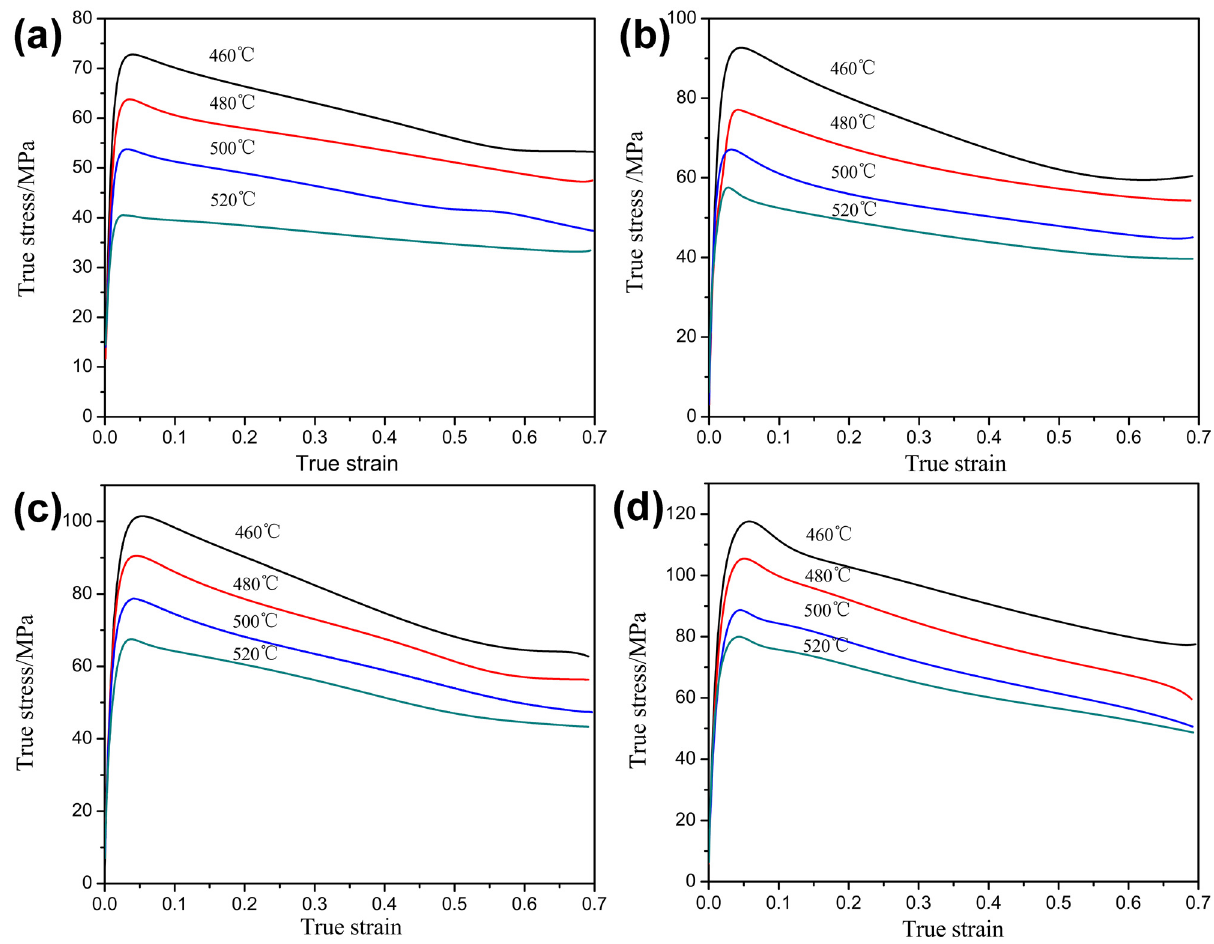
Figure 4: The true stress – strain curves at di ff erent strain rates: ( a ) ε ̇ = 0.01 s − 1 ; ( b ) ε ̇ = 0.1 s − 1 ; ( c ) ε ̇ = 1 s − 1 ; and ( d ) ε ̇ = 5 s − 1 .